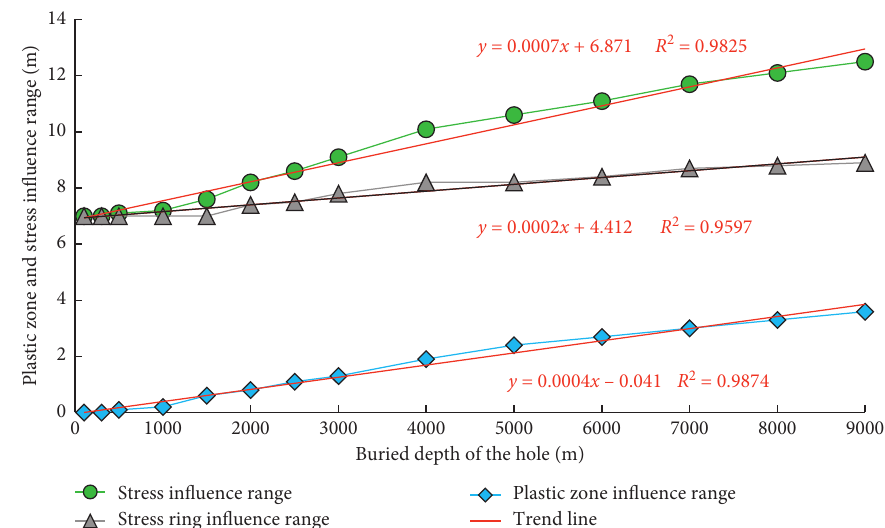
Figure 9: Relationship between the plastic area range of holes and the influence range of stress under the condition of sandy